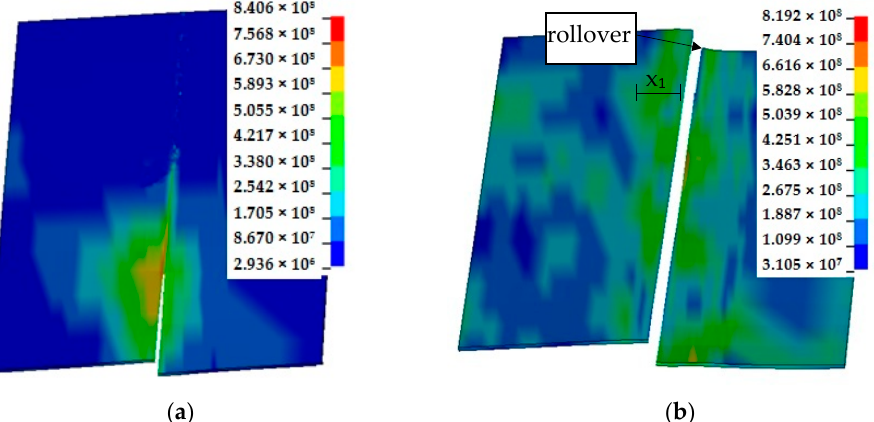
Figure 7. Formation of slit edges along the shearing line: ( a ) 25% of sheet length; ( b ) 100% of sheet length ( c h = 0.04 mm, α = 15°).